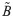
The relationship between the overall effective stiffness and mid-span deflection.The overall effective stiffness B˜ is defined as the product of the bending moment M of the portion subjected to pure bending and the mean curvature φ of the beam axis. The curve of overall effective stiffness can be divided into four stages, including steady increasing period, concave descending period, steady descending period and convex descending period.